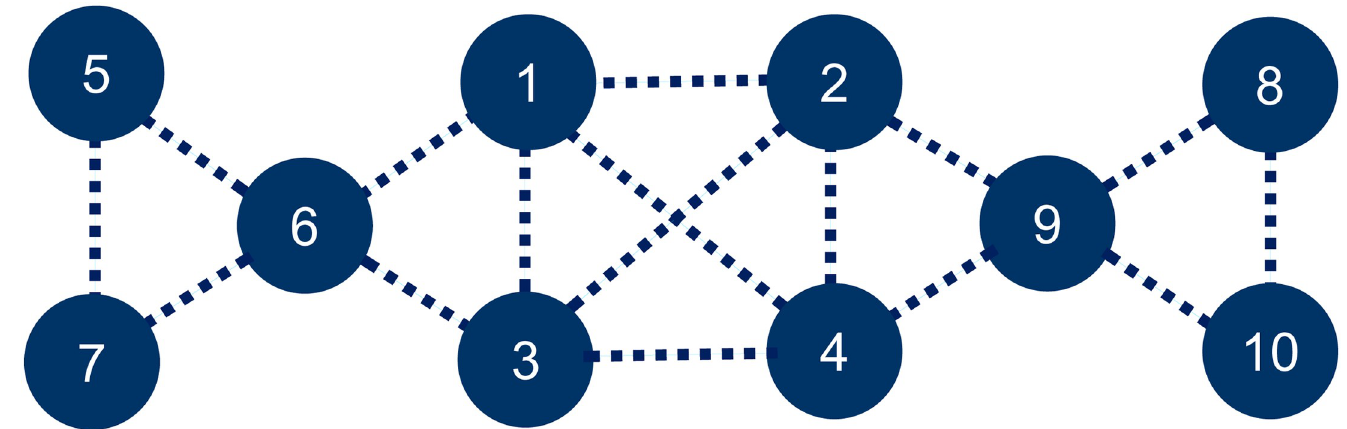
Fig 2. Example population. A population of ten possible activities, where activities {1, 2, 3, 4} are considered to be of high contact rates, and therefore assigned with a higher contact value α i = 4, i = 1, ... , 4. The rest of the activities are considered of low contact rates, and assigned with a lower contact value α i = 1, i = 5, ... , 10.